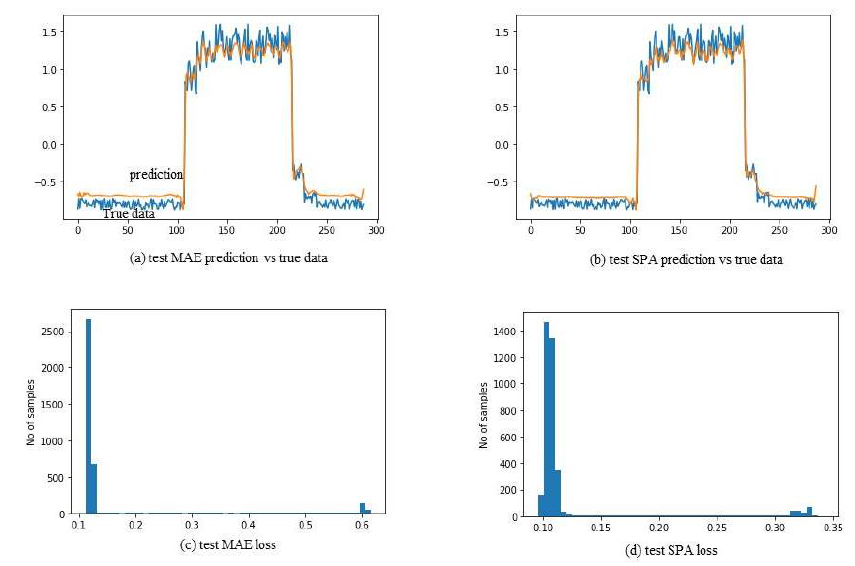
Figure 5. Results for the LSTM-based AE. Plots ( a , b ) show the true vs. predicted values for MAE and SPA loss functions, respectively. Plots ( c , d ) show the test loss for MAE and SPA loss functions,